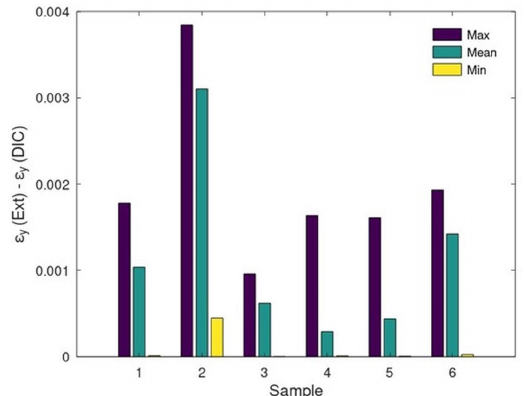
Figure 8. Maximum, mean and minimum